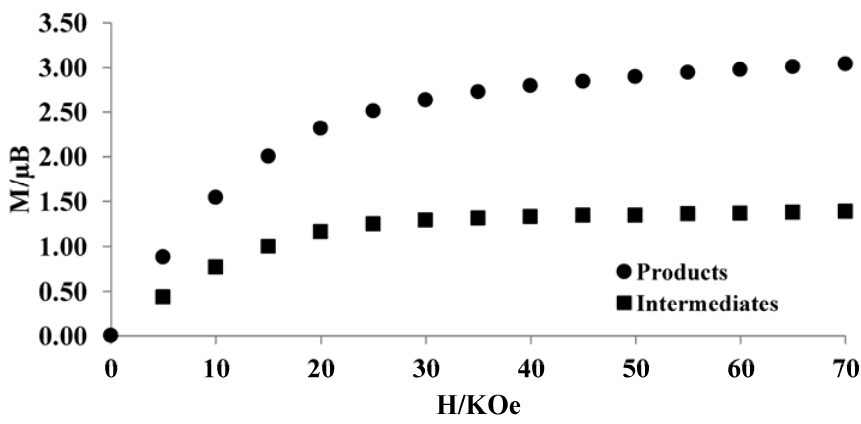
Figure 3. Isothermal (2 K) magnetization curves of the reaction of 1.02 ± 0.05 mM Cr(VI) and 15.0 ± 0.8 mM GSH in 100 mM glycine, pH 2.8, in D 2 O.